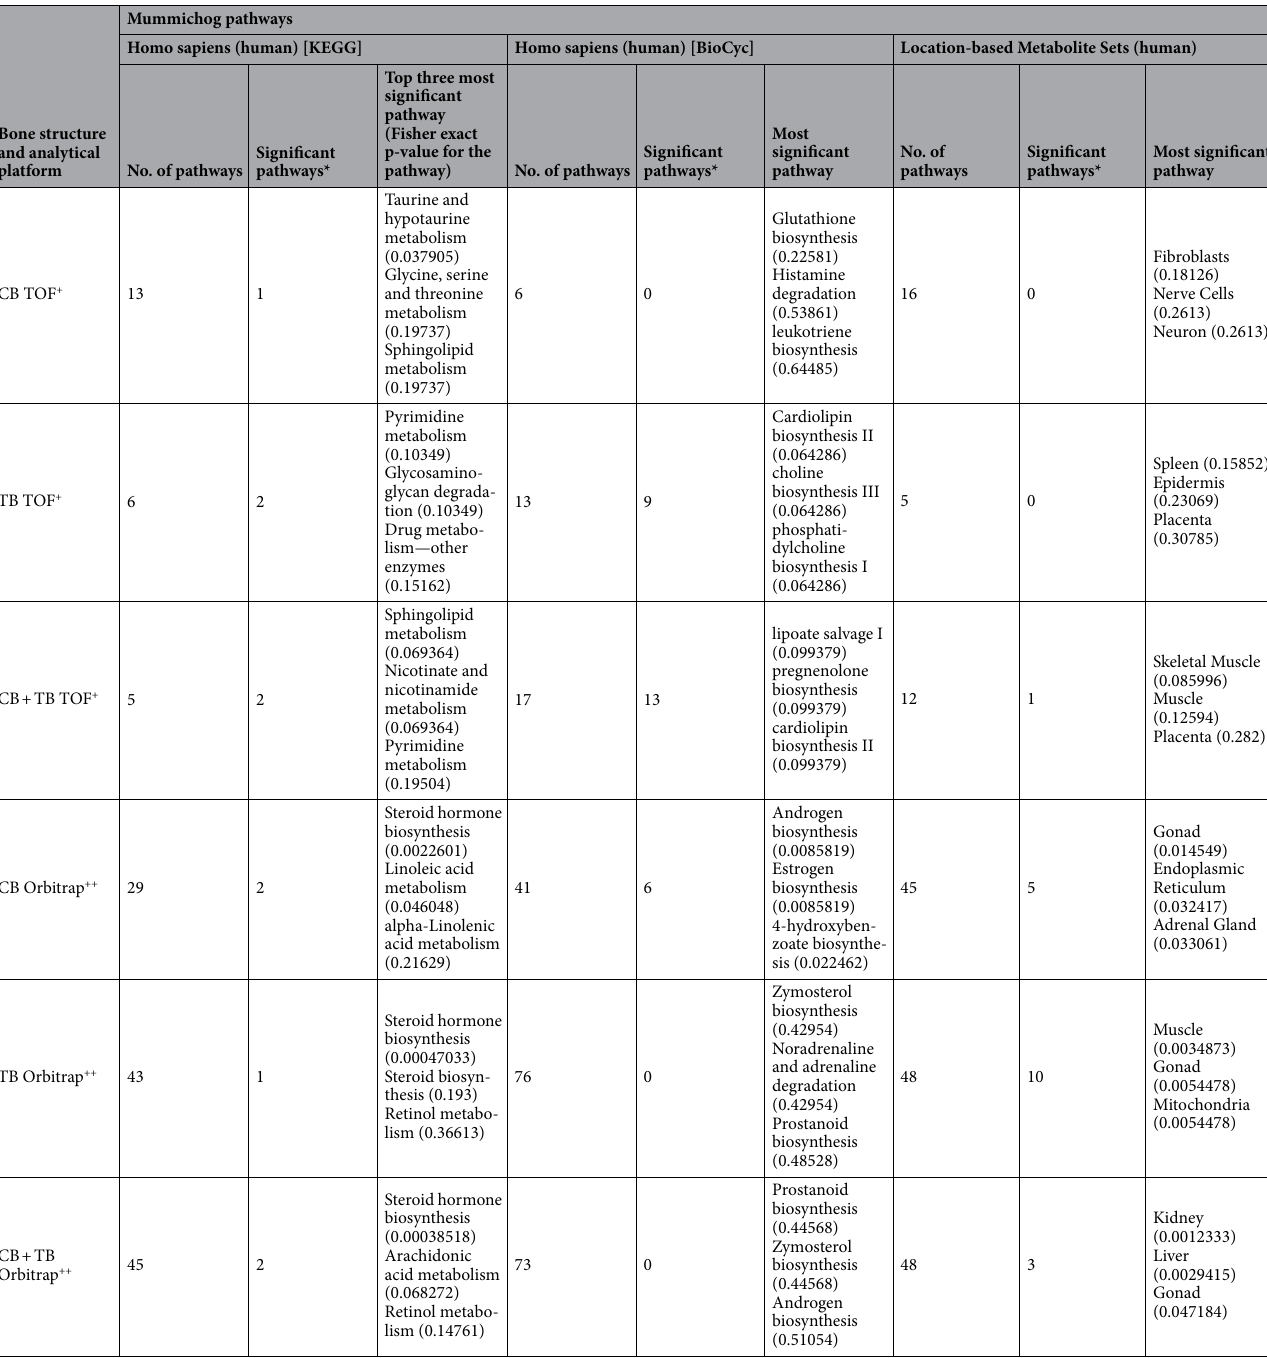
Table 1. Mummichog pathways in HSR metabolomic study. Affected pathways found in the comparison of metabolites from the control and affected groups of HSR for cortical (CB), trabecular (TB), and combined bone structures after LC-HRMS measurements using HF-UPLC-IM-TOF-HRMS and nano-UHPLC-Orbitrap- HRMS platforms. + Pathways explored combining C18 and HILIC results. ++ Pathways explored using C18 results. *Fisher exact p-value p <